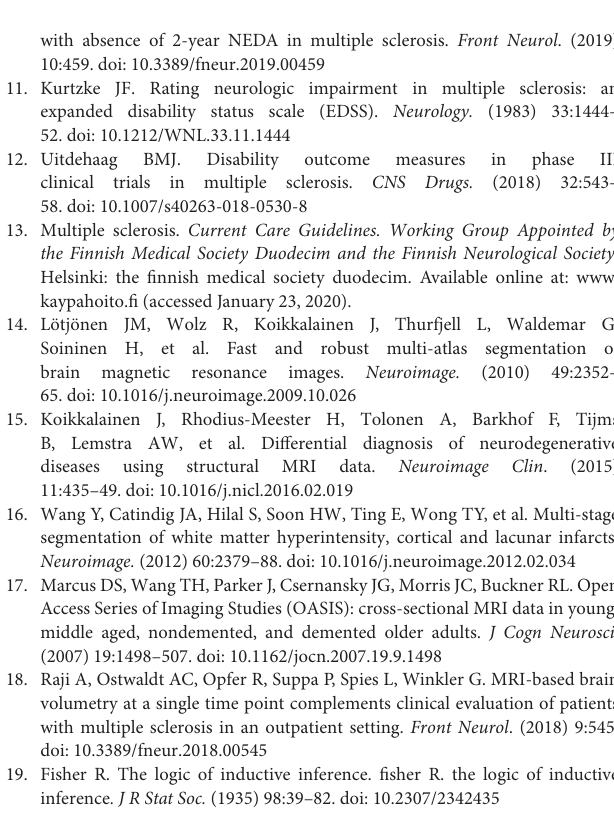
Supplemental Figure 1 | Example of brain segmentation by cNeuro: Upper left panel shows a T1 image of one of the study patients and upper right its segmentation for the different brain region volume measurement. Lower left panels shown a FLAIR image of the same patients and lower right panel white matter MS lesion detection for the automated lesion volume measurement by